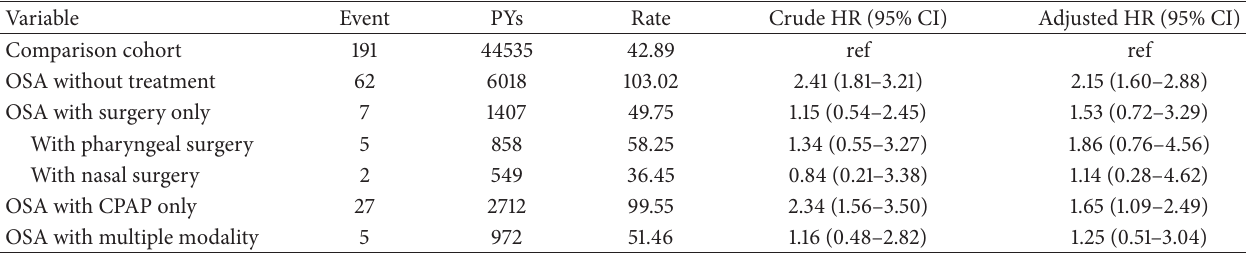
Table 3: Glaucoma incidence rates and multiple Cox regression model measured hazard rates ratio among comparison cohort and OSA cohort with different managements.